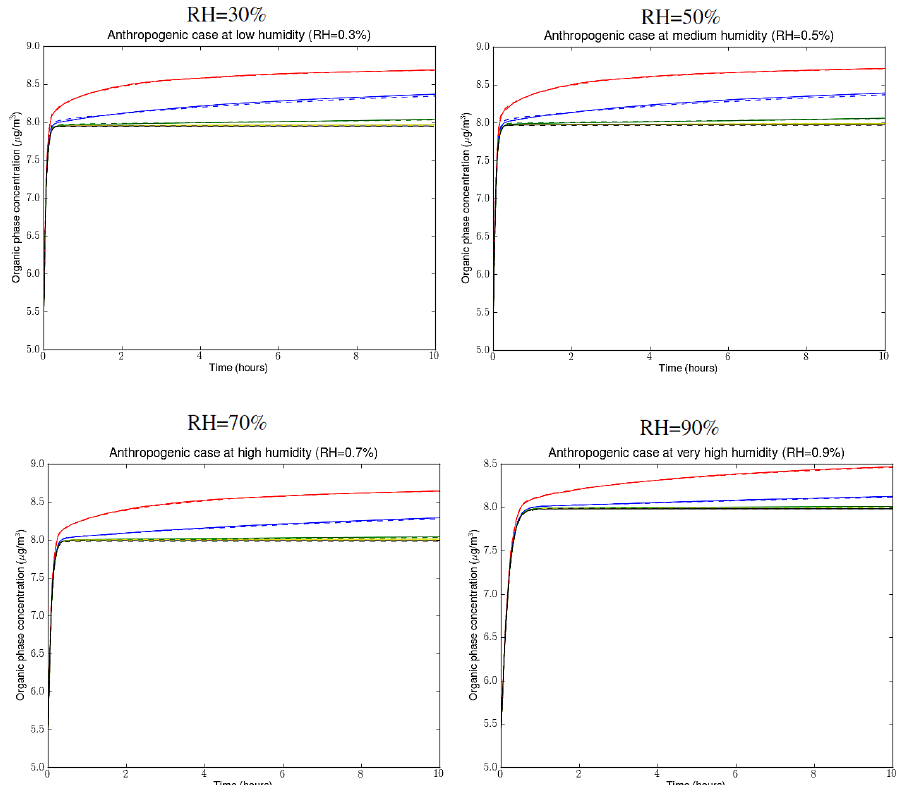
Figure 9. Evolution of concentrations in organic phases for the anthropogenic case at various humidities, with initial concentrations equal to one tenth of the concentrations at equilibrium and 5µgm − 3 of non-volatile compounds for N layer = 5 (plain lines) and N layer = 4 (dashed lines) for several organic-phase diffusivity: D org = 10 − 19 m 2 s − 1 (red), D org = 10 − 20 m 2 s − 1 (blue), D org = 10 − 21 m 2 s − 1 (green), D org =